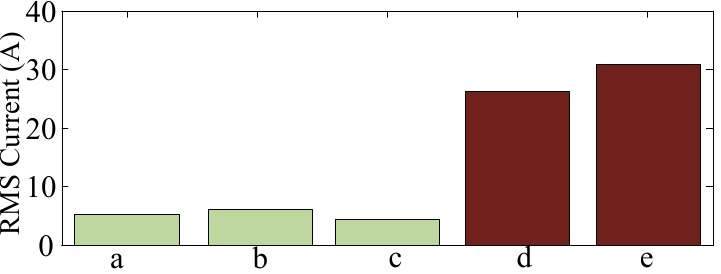
Figure 20. Root-Mean-Square (RMS) results with different methods.